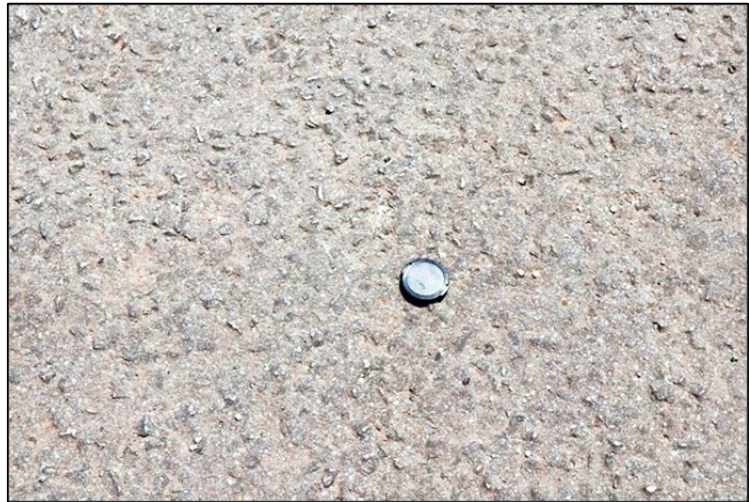
Figure 19. March 2020—condition of the Cape seal.